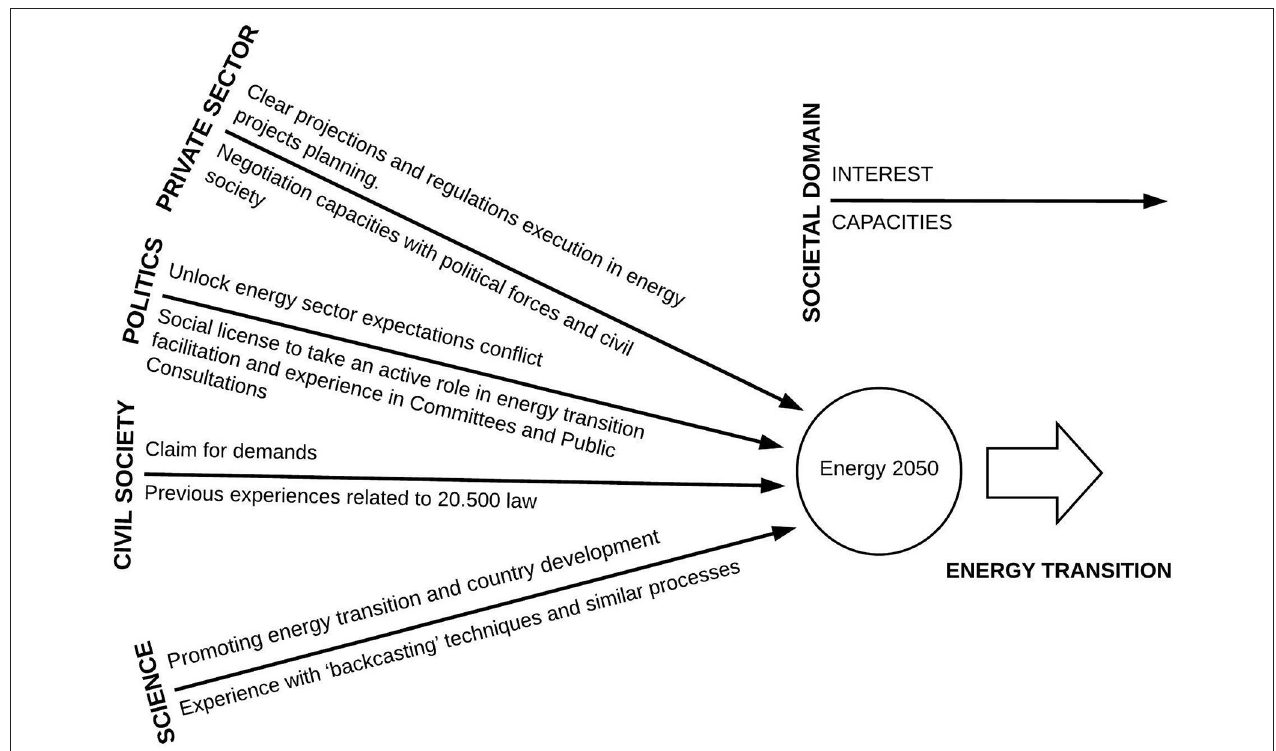
FIGURE 2 | Boundary conditions of